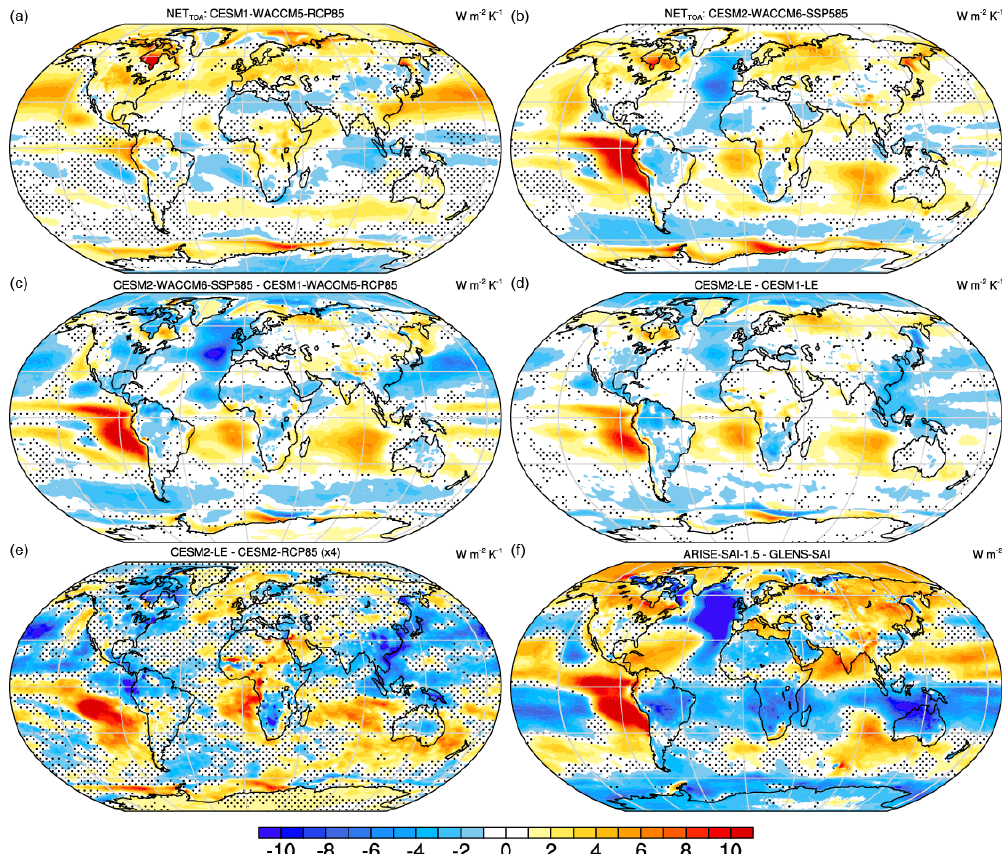
Figure A1. Normalized response in net incoming top-of-atmosphere radiative flux (RTMT) estimated from the change between 2020–2039 and 2050–2069 per degree global warming for unmitigated (a) CESM1-WACCM5-RCP85 and (b) CESM2-WACCM6-SSP585 simulations, and (c) their difference ( a minus b ). Also shown is (d) the analogous difference for CESM1-LE and CESM2-LE and (e) CESM2-RCP85 and CESM2-LE (scaled by 4). The difference between the geoengineered climate states in ARISE-SAI-1.5 and GLENS-SAI is shown in panel (f) . Units for all panels are Wm − 2 K − 1 , except in panel (f) where units are Wm − 2 , and stippled regions indicate differences that are less than twice the ensemble standard